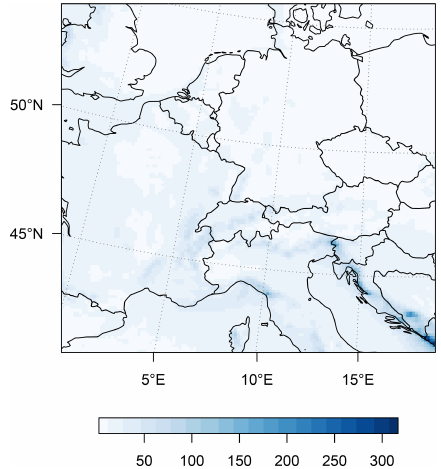
Figure B1. Training 1955–2020: mean-squared error (MSE, based on precipitation data in mmd − 1 ) for each grid cell for the precipi- tation predictions.